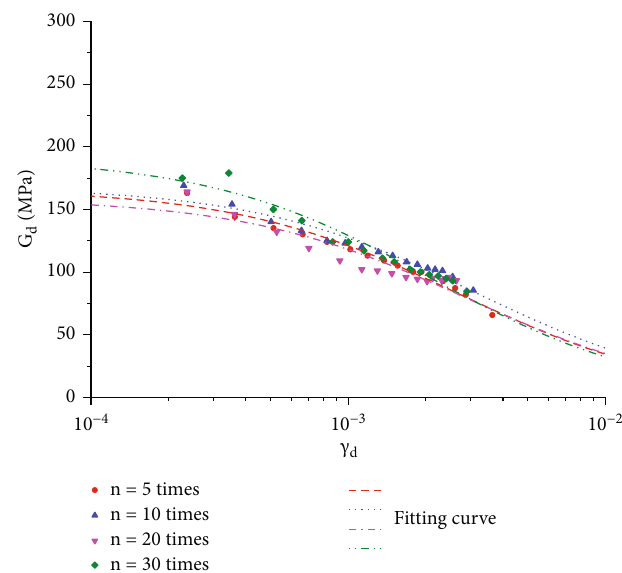
Figure 14: Dynamic shear modulus-strain curves under di ff erent freeze-thaw cycles (-10 ° C).